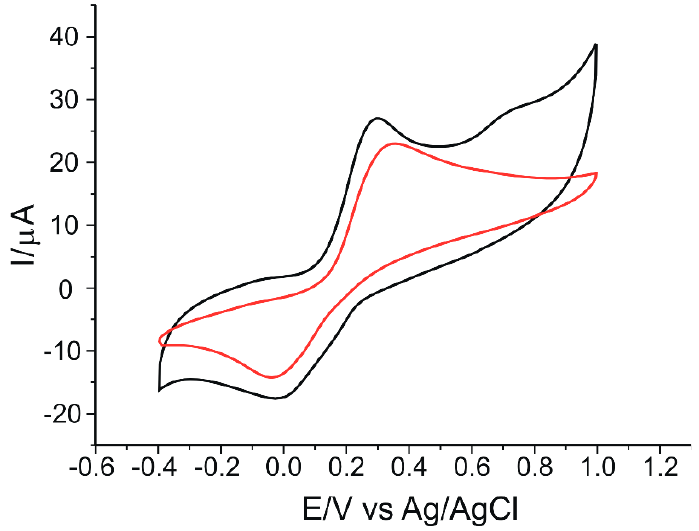
Figure 10. Cyclic voltammograms of GO/SPCE (red line) and GO-Peptide/SPCE (black line) immersed in 10 − 3 M rosmarinic acid-0.1 M PBS solution (pH 6.5). Scan rate: 0.05 V·s − 1 .